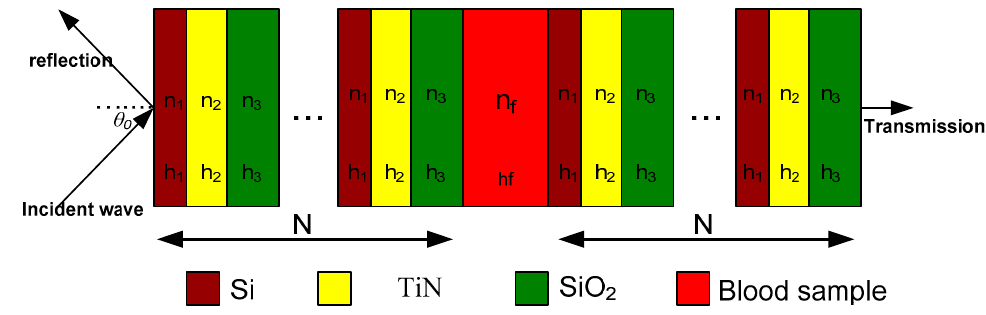
Figure 1. Graphical depiction of a 1D-TPC with a defect